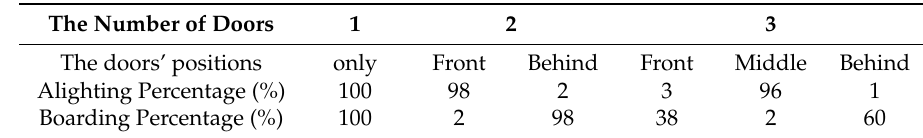
Table A1. Boarding and alighting behaviors for multi-policy.